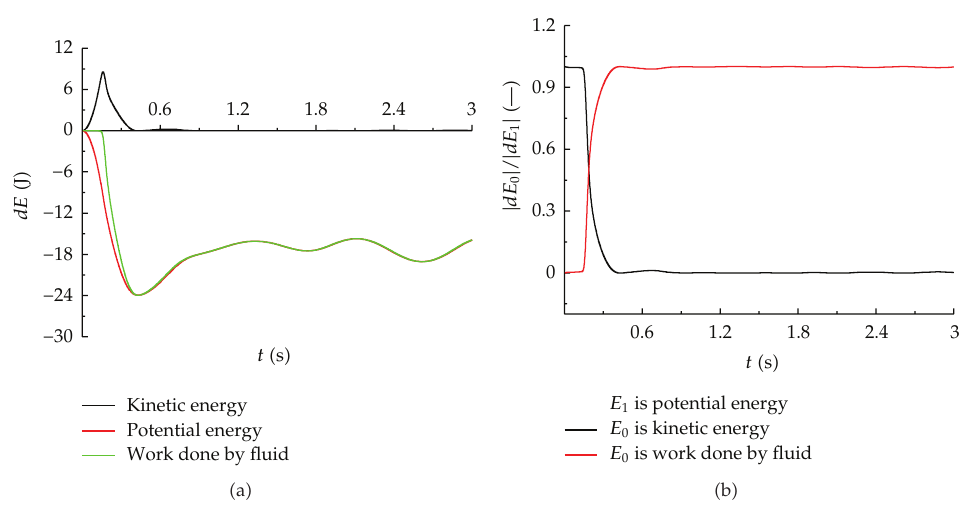
Figure 4: Time histories of accumulative variation of energy (cid:2) a (cid:3) and its ratio (cid:2) b (cid:3) for free-falling wedge.